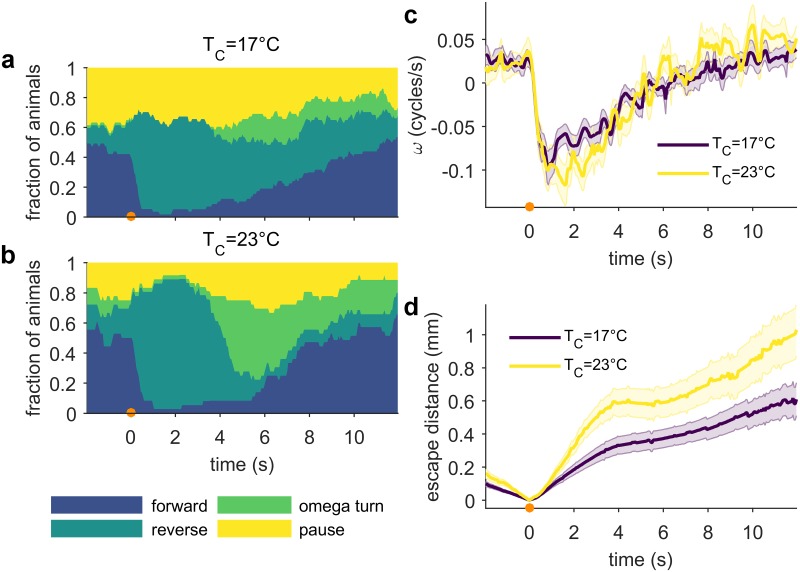
Animals cultivated at lower temperatures exhibit reduced escape responses.Animals were reared in incubators set to 17 °C and 23 °C. All behavioral experiments were performed at 23 °C. Stimulus (100 ms 75 mA, focused by 75 mm lens) is applied at t = 0 s. (a) and (b) show fraction of animals raised at each temperature in each of the four behavioral states after a thermal stimulus. n at 17 °C ≥ 53; n at 23 °C ≥ 32. (c) Mean phase velocity after stimulus. Shaded regions indicate the standard error of the mean. (d) Mean escape distance. Shaded regions indicate the standard error of the mean. Full ethograms shown in S7 Fig.